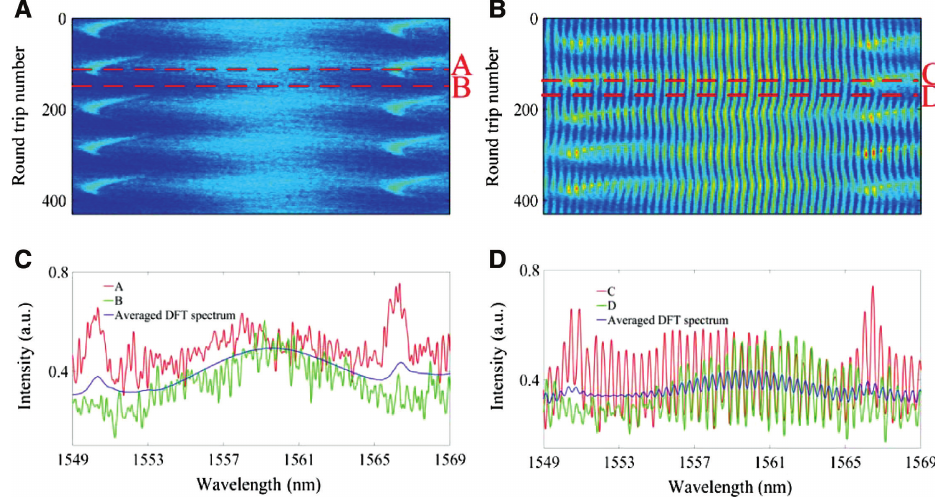
Figure 10: Pulsating soliton bunch generated in a fiber laser with a graphene SA on a microfiber. (A) and (B) Shot to shot spectra of the one-soliton and dual-soliton bunch, respectively. (C) Single-shot spectra at round trips A (red) and B (green) in (A). (D) Single-shot spectra at round trips C (red) and D (green) in (B). Averages (blue) of 9762 consecutive single-shot spectra in both cases are also shown in (C) and (D), respectively. Reproduced with permission [220]. Copyright 2018, The Optical